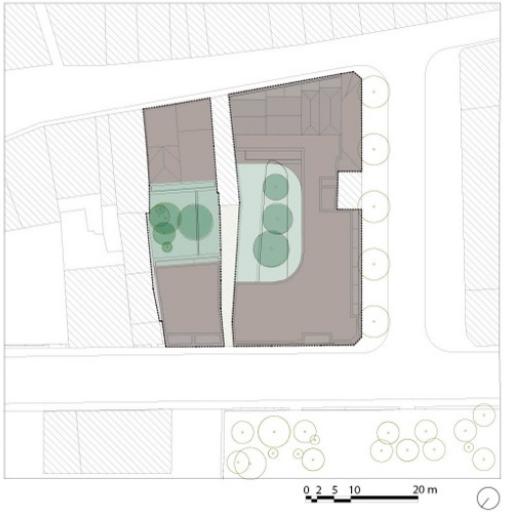
Figure 4. Braga. General plan.